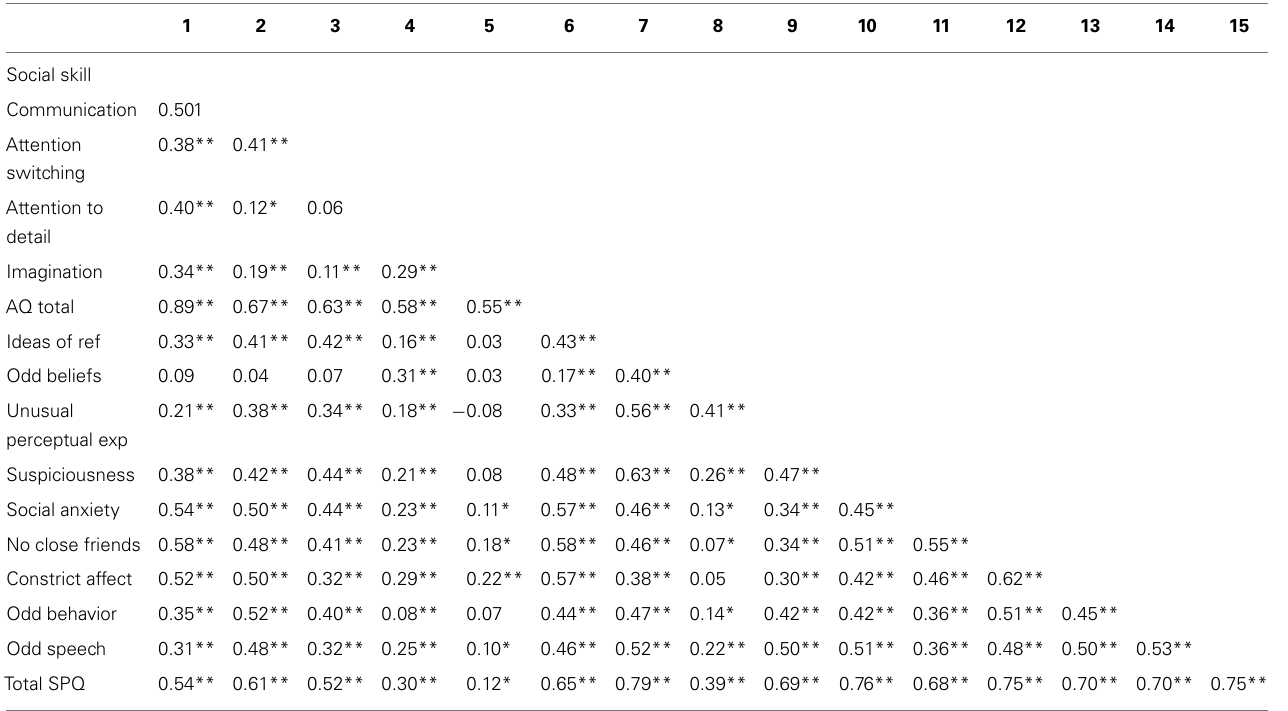
Table 2 | Correlation matrix for totalAQ, total SPQ, and individual subscales